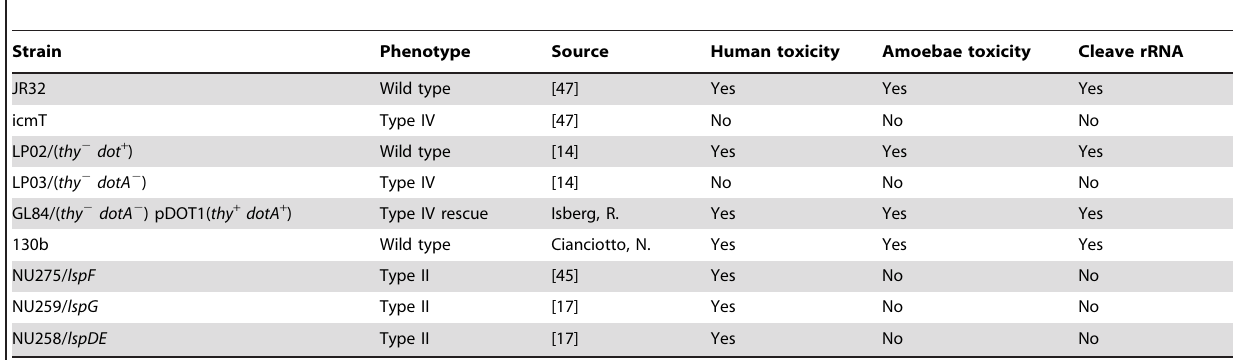
Table 3. Effect of L. pneumophila type II and type IV secretion mutants on D. discoideum mitochondrial rRNA cleavage.